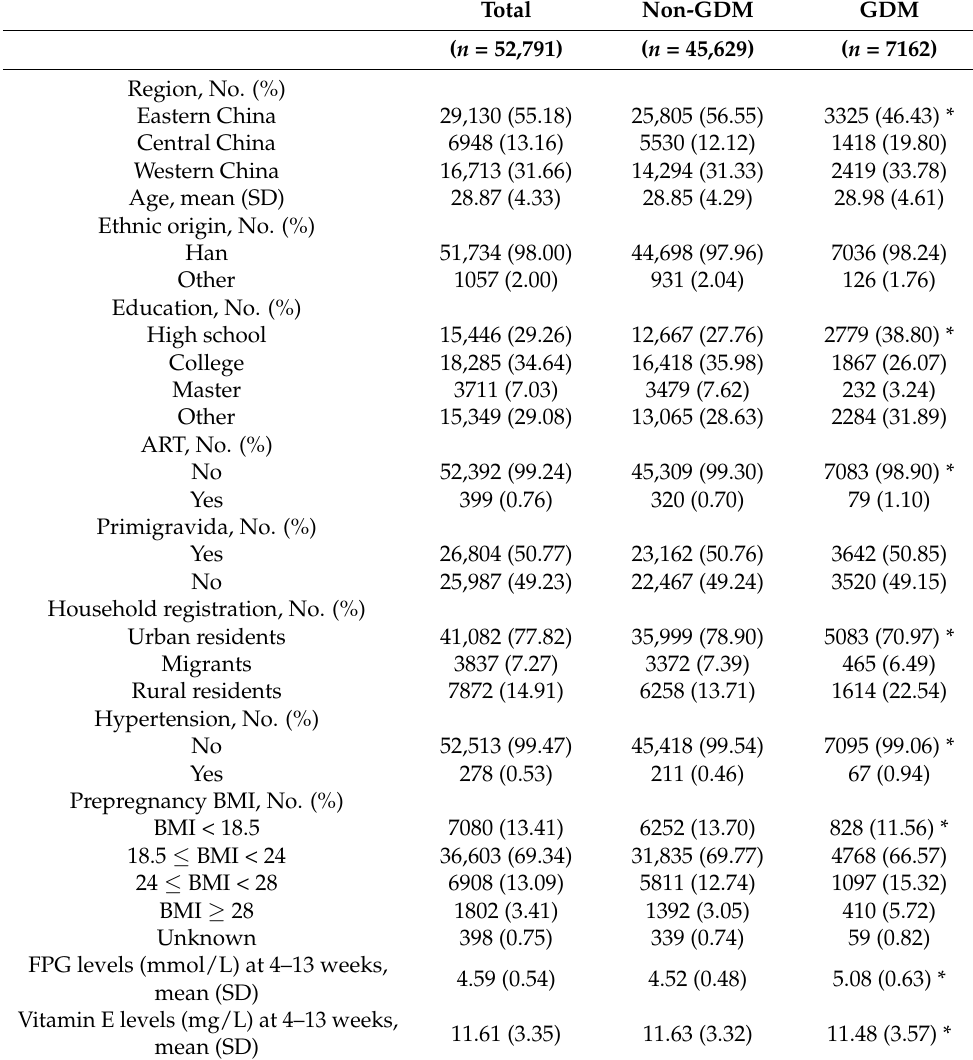
Table 1. Characteristics of